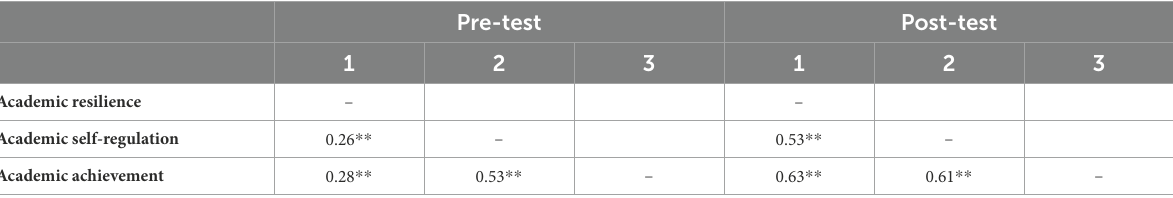
TABLE 3 Correlation coefficients of research variables.